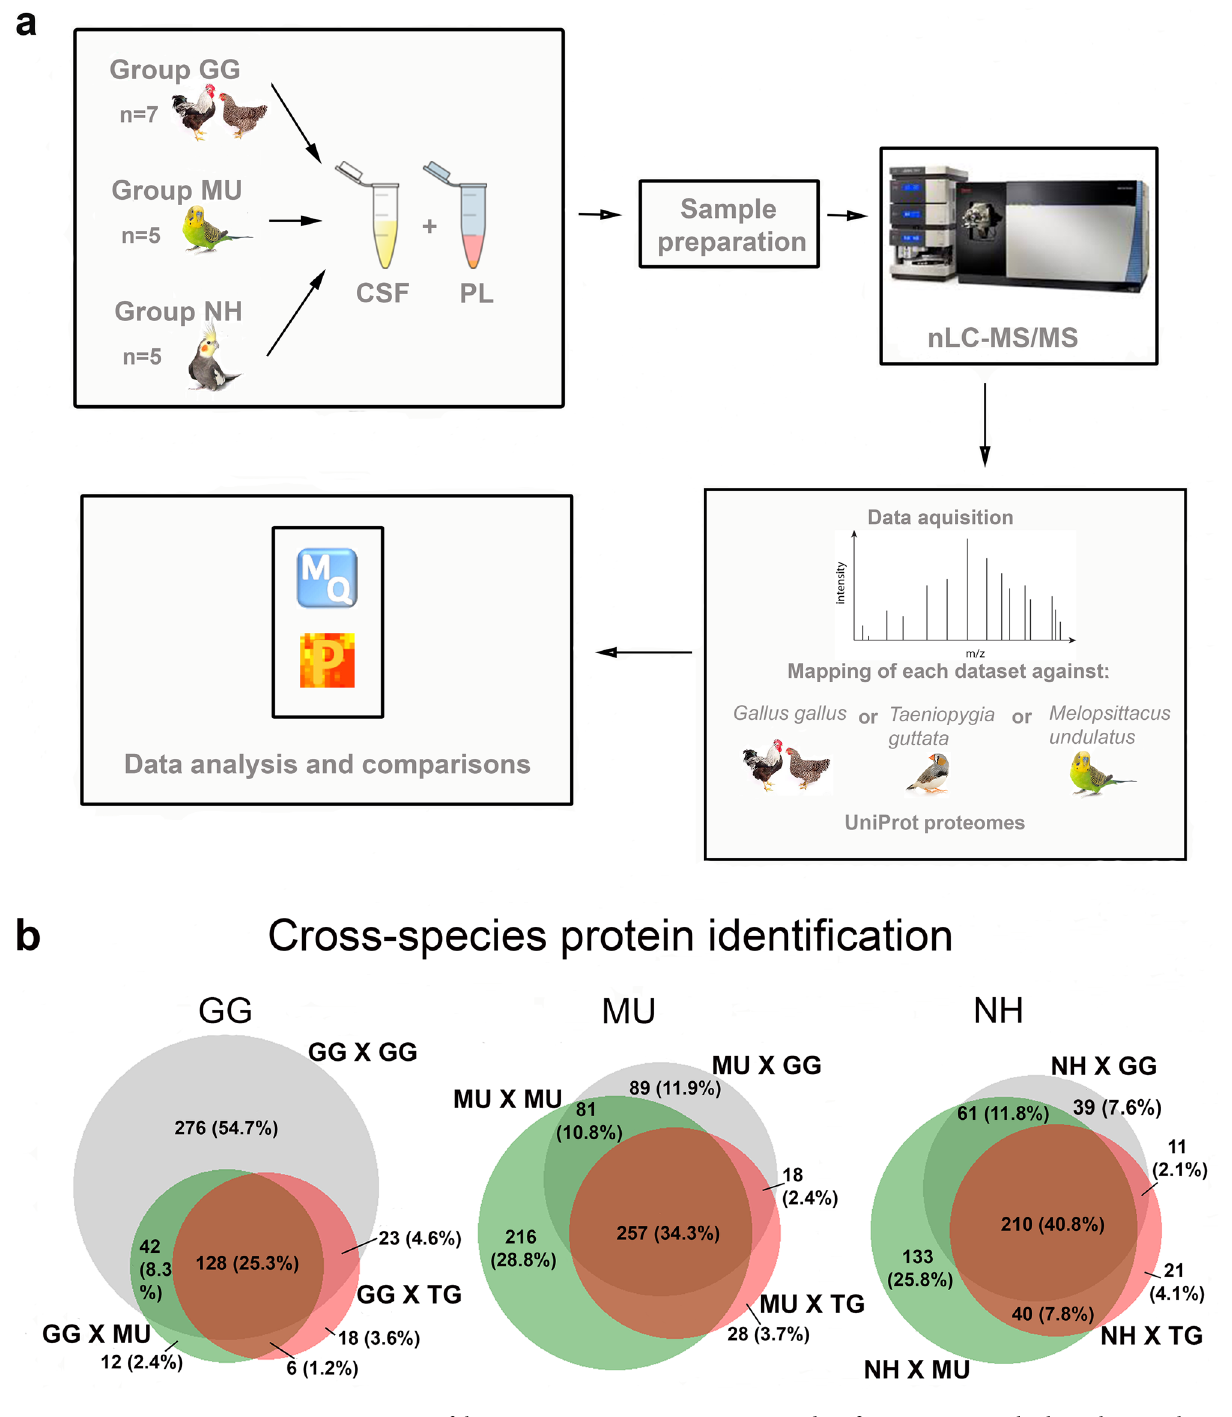
Figure 1. Comparison of the nLC-MS/MS cross-species protein identification success in both cerebrospinal fluid (CSF) and plasma (PL) samples of chickens (GG), budgerigars (MU) and cockatiels (NH), after mapping to three selected avian reference proteomes GG, MU and Taeniopygia guttata (TG). ( a ) The overview of the study design and mapping approach is schematically illustrated. ( b ) Venn diagrams show the proportions of proteins identified based on the different reference proteomes of GG (grey), TG (red) and MU (green) for GG, MU and NH (BioVenn, http://www.biove